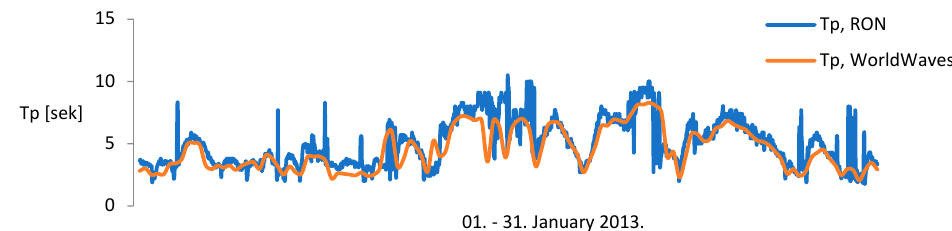
Figure 4. Tp time series from WW database (location 4) and RON buoy “Ancona” (13°43 ′ 10 ″ E–43°49 ′ 26 ″ N) .